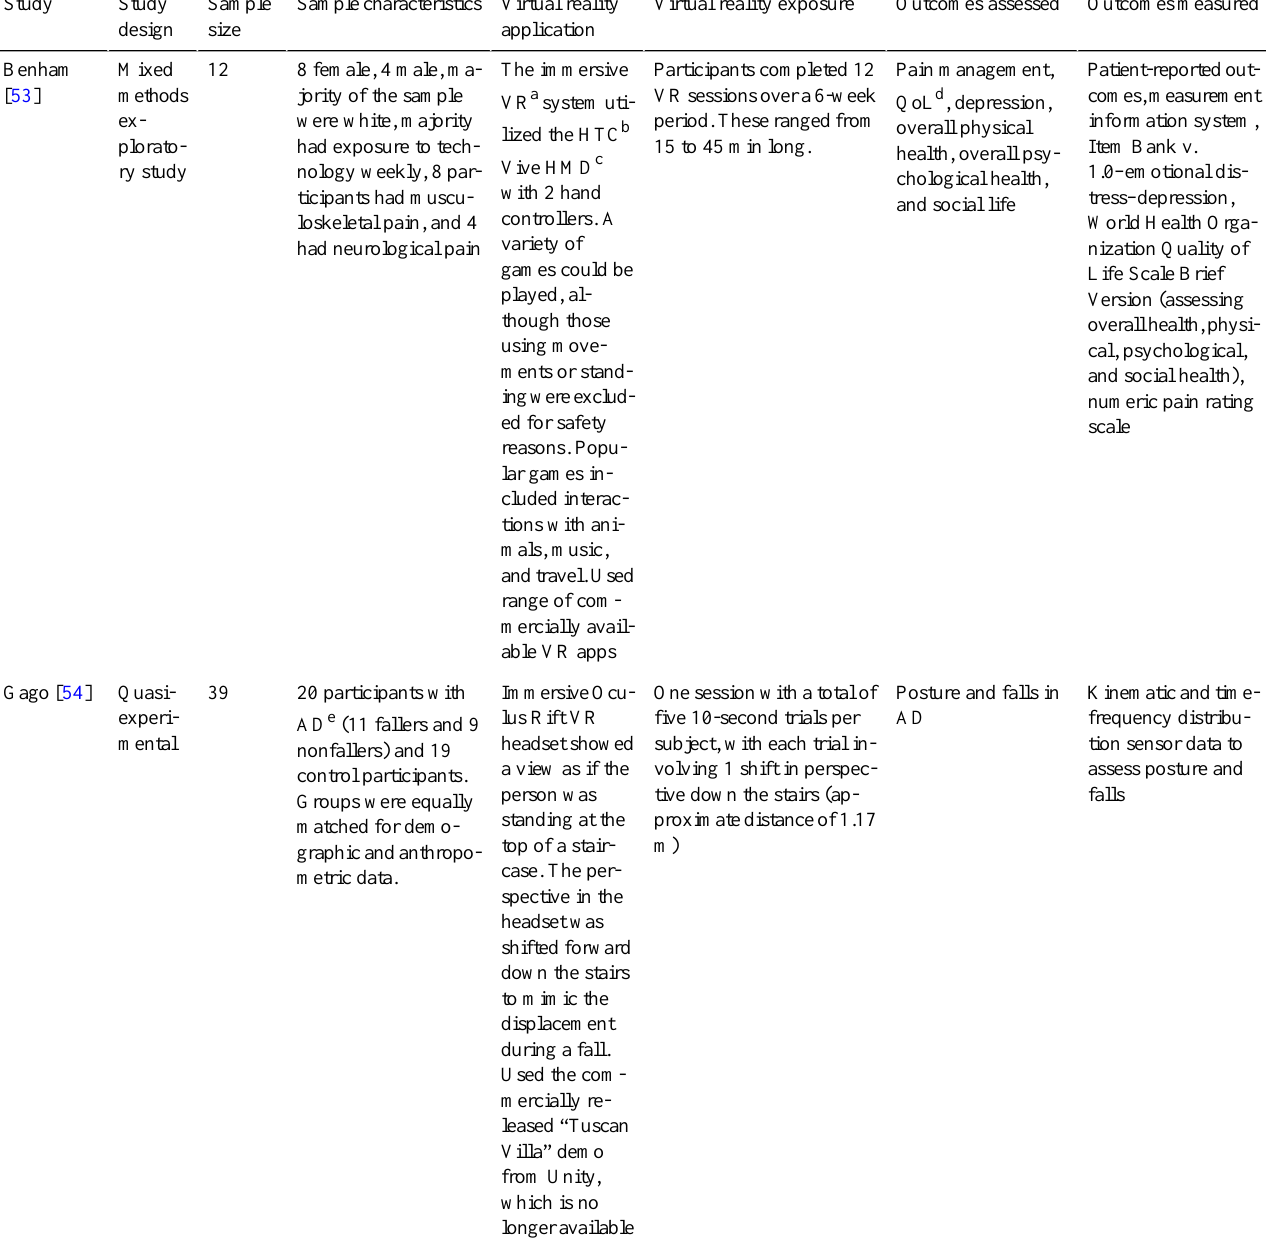
Table 1. Details of study design, virtual reality therapy, and health